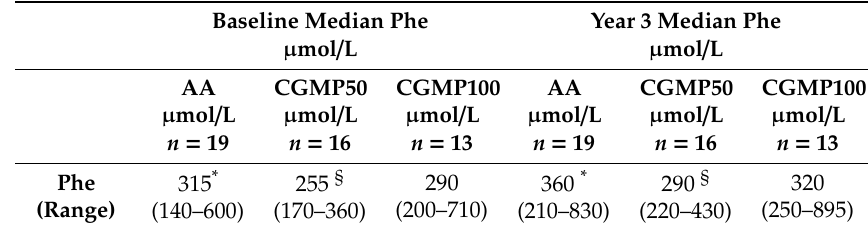
Table 5. Median (range) blood phenylalanine concentrations from baseline to year 3 in AA, CGMP50 and CGMP100.